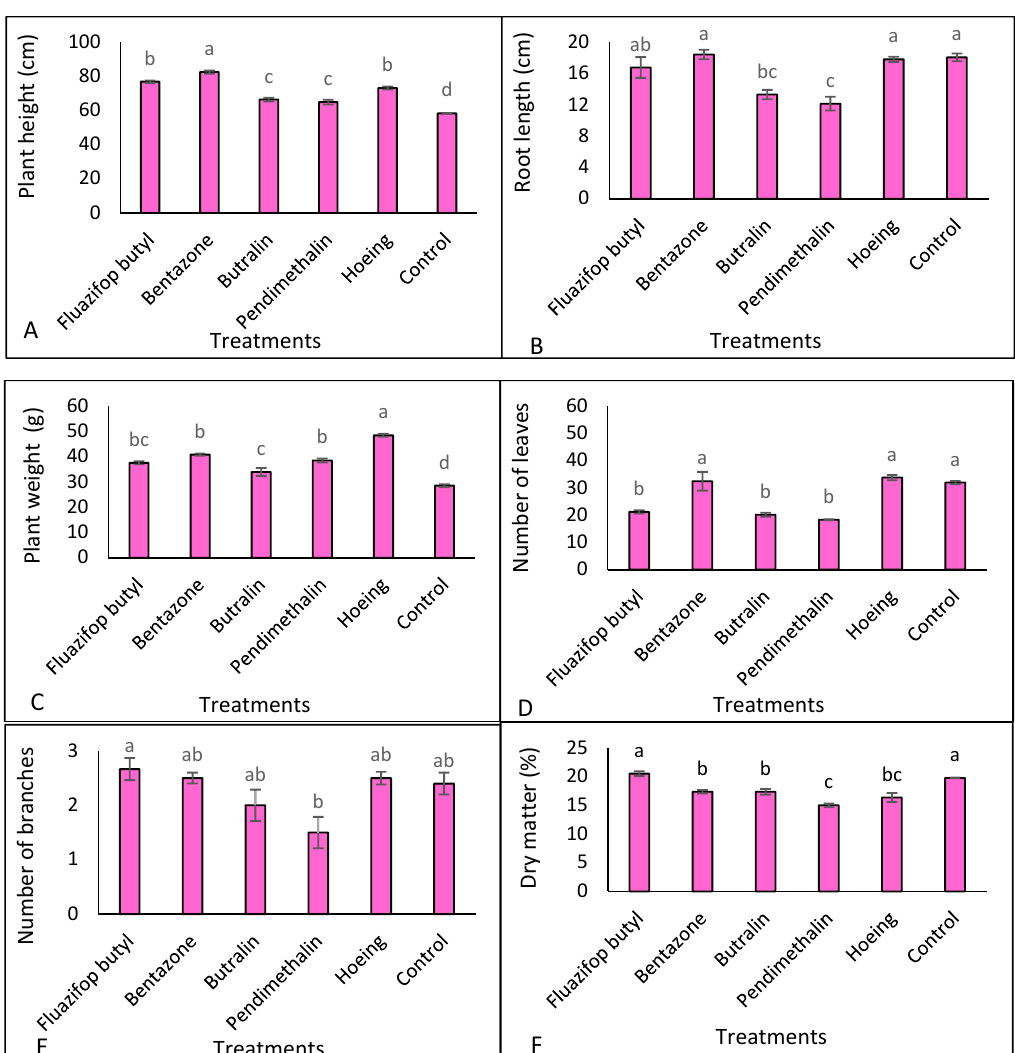
Figure 3. Effect of pre- and postemergence herbicides on plant height ( A ), root length ( B ), plant fresh weight ( C ), number of leaves ( D ), number of branches ( E ), and dry matter % ( F ). Different letters indicate significant differences between treatments (Duncan test at p < 0.05); vertical bars indicate standard error.